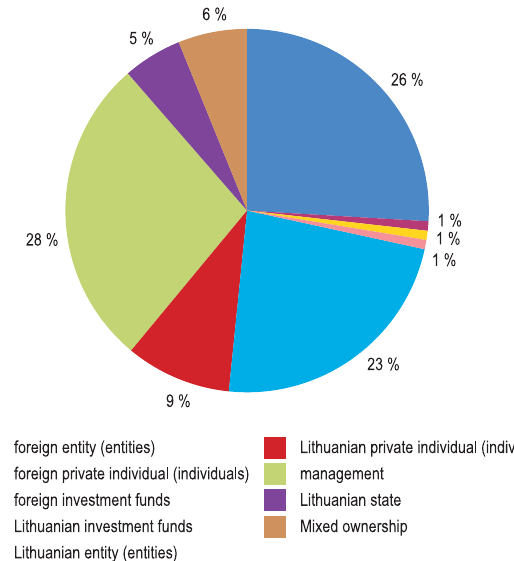
Fig. 3. Ownership structure in Lithuanian companies